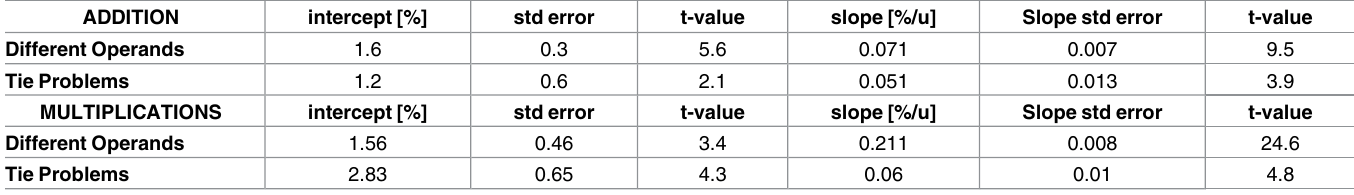
Table 3. results of the linear regressions for error rates (in %) using the product of the operands as independent variable.